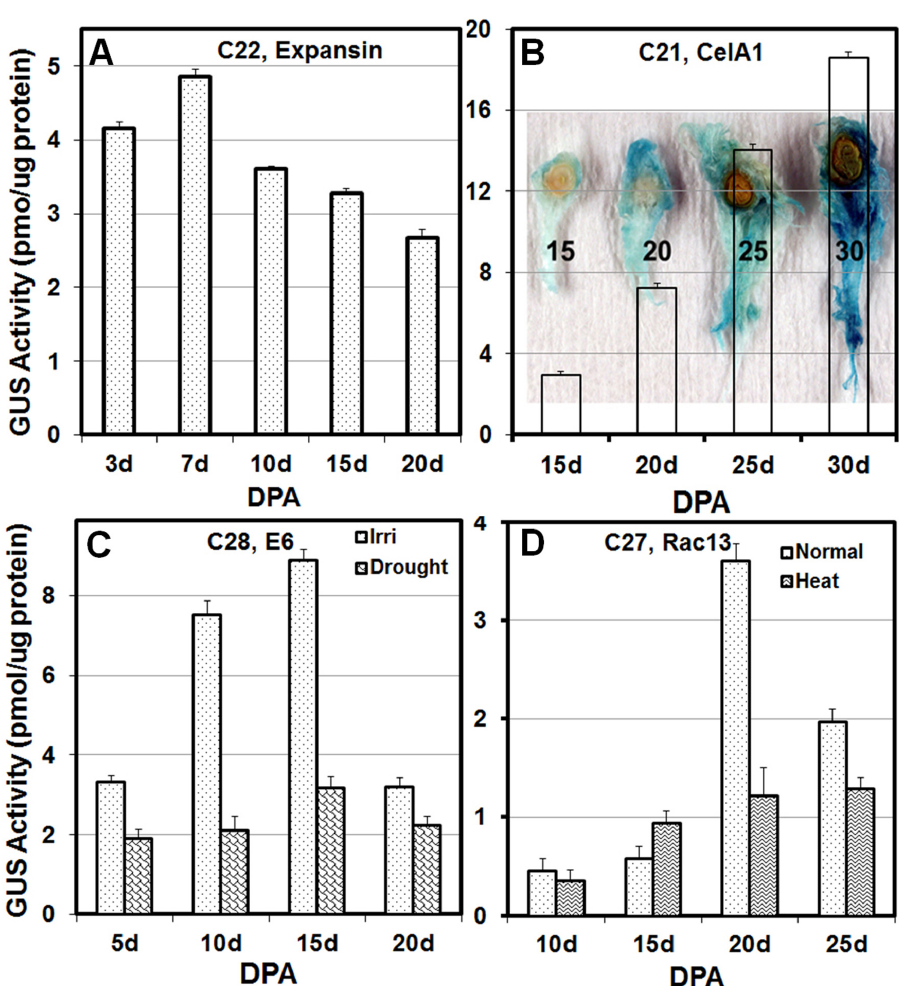
Fig 5. GUS activities measured by fluorometric quantification at different fiber developmental stages in transgenic plants. (A) C22- Expansin :: GUS , (B) C21- CelA1 :: GUS , (C) C28- E6 :: GUS and (D) Rac13 :: GU S grown under normal or stressed conditions. The GUS activities were determined by measuring fluorescence on Tecan 200 fluorometer using 360nm and 465nm as excitation and emission wavelengths, respectively and expressed as pmol of 4-MU per min per μ g total